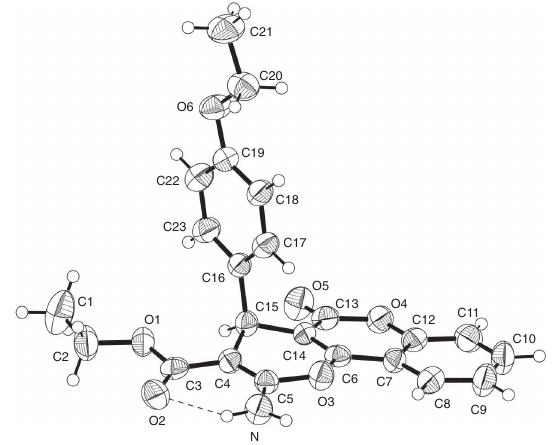
Table 1: Data collection and handling.